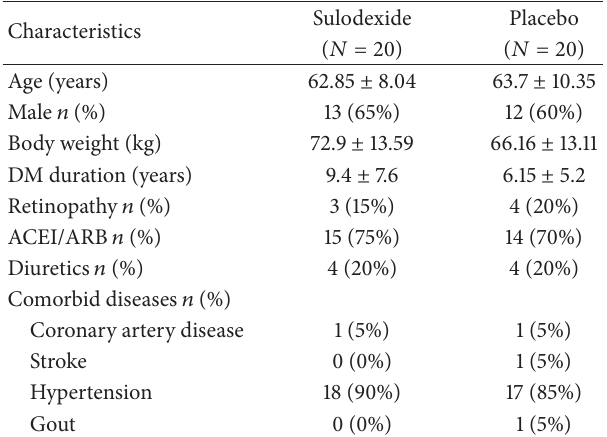
Table 1: Baseline characteristics of study